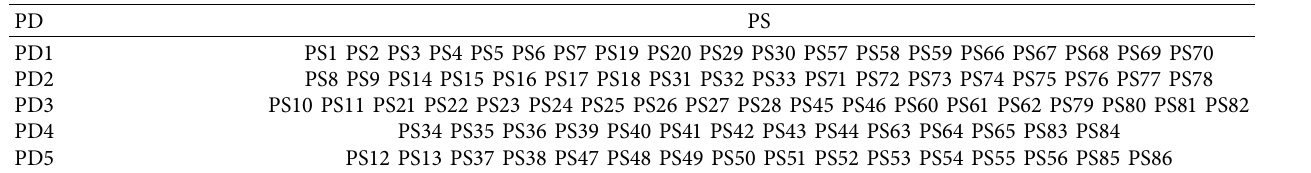
Figure 4: Distribution network diagram of multidepot and multistation. Table 5: PSs served by different PDs before optimization.